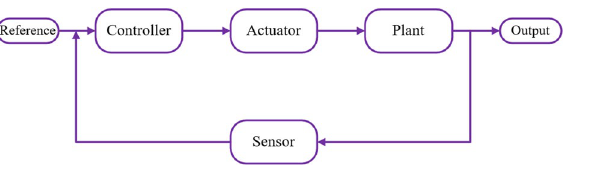
Figure 7. General closed-loop control